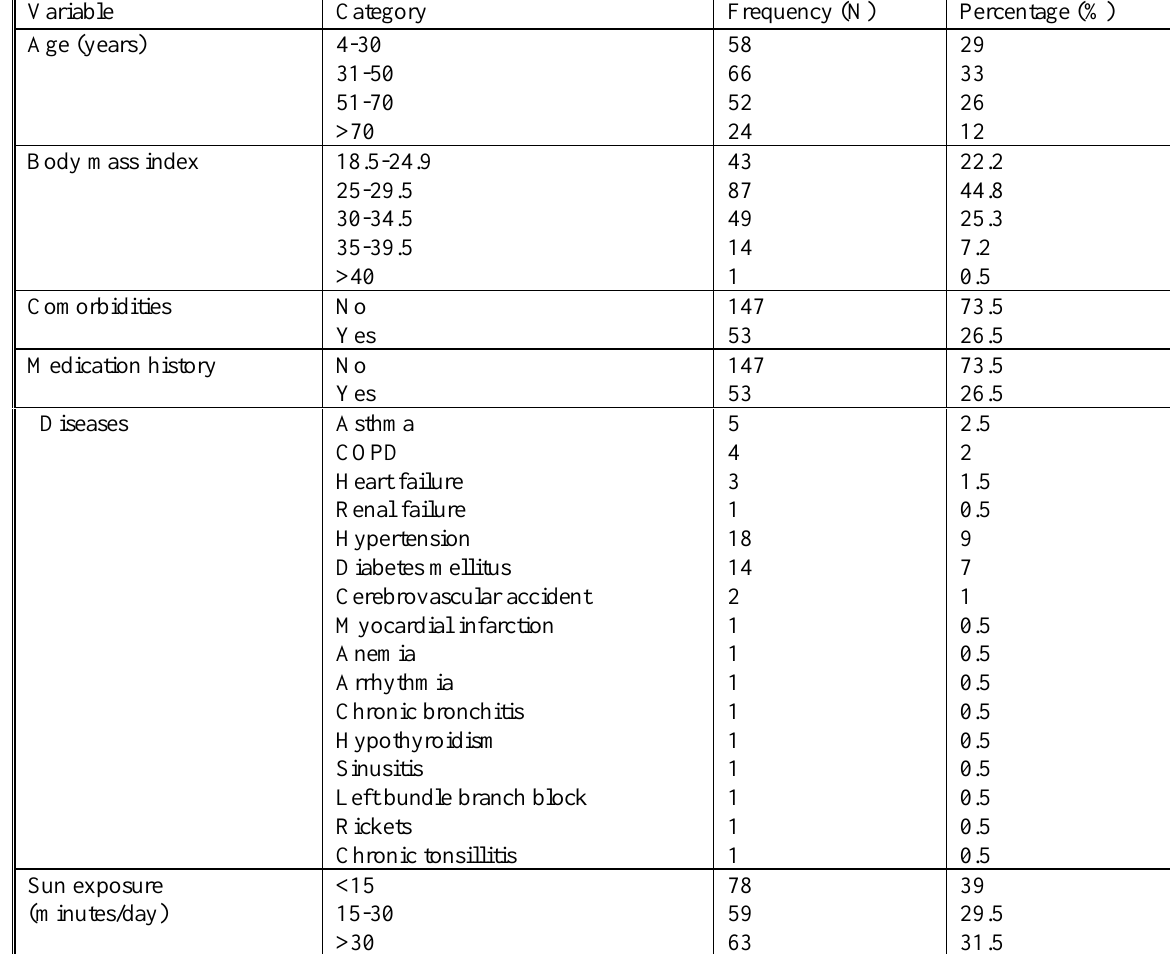
Table 1. Patients’